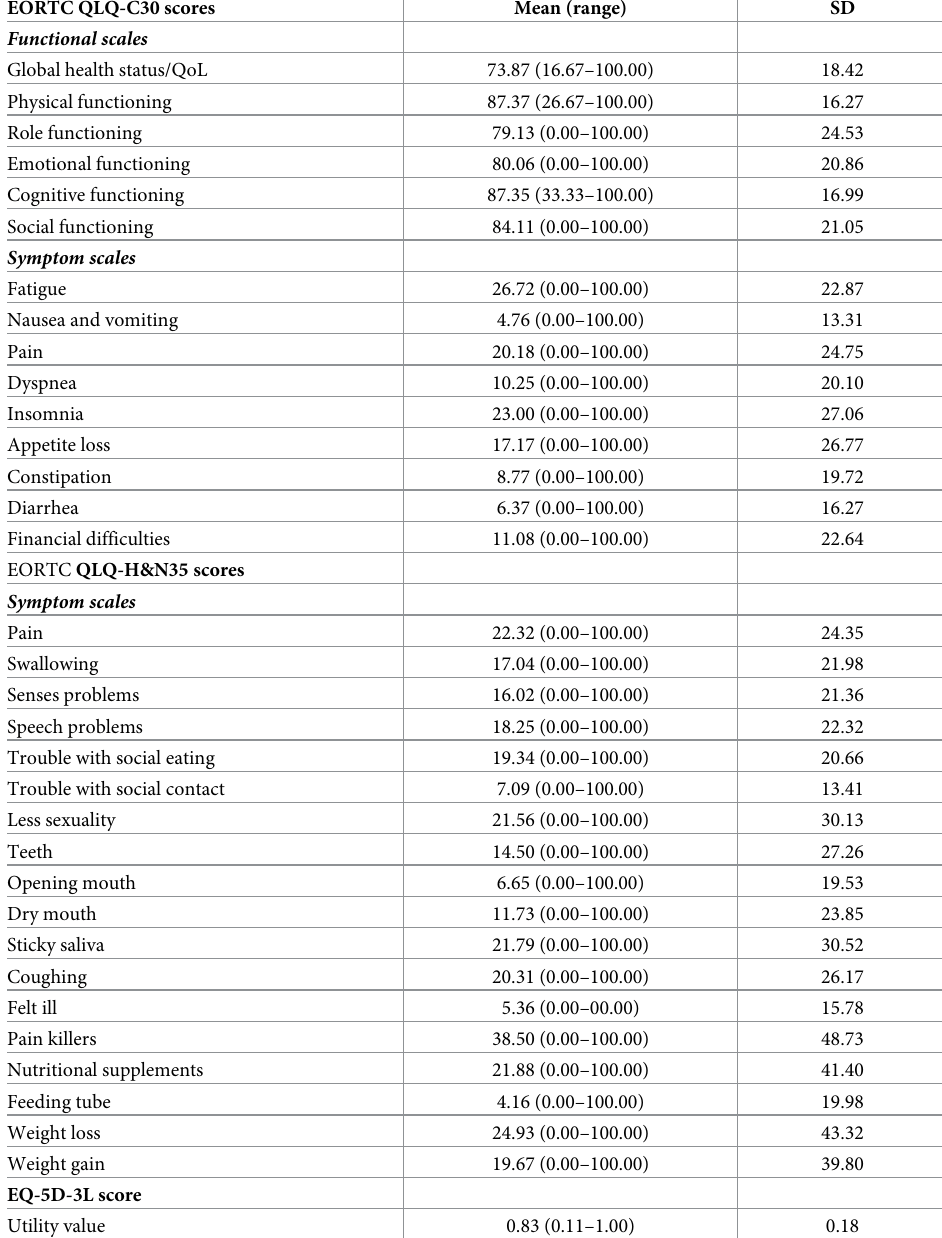
Table 2. Summary results of HRQoL data derived from 361